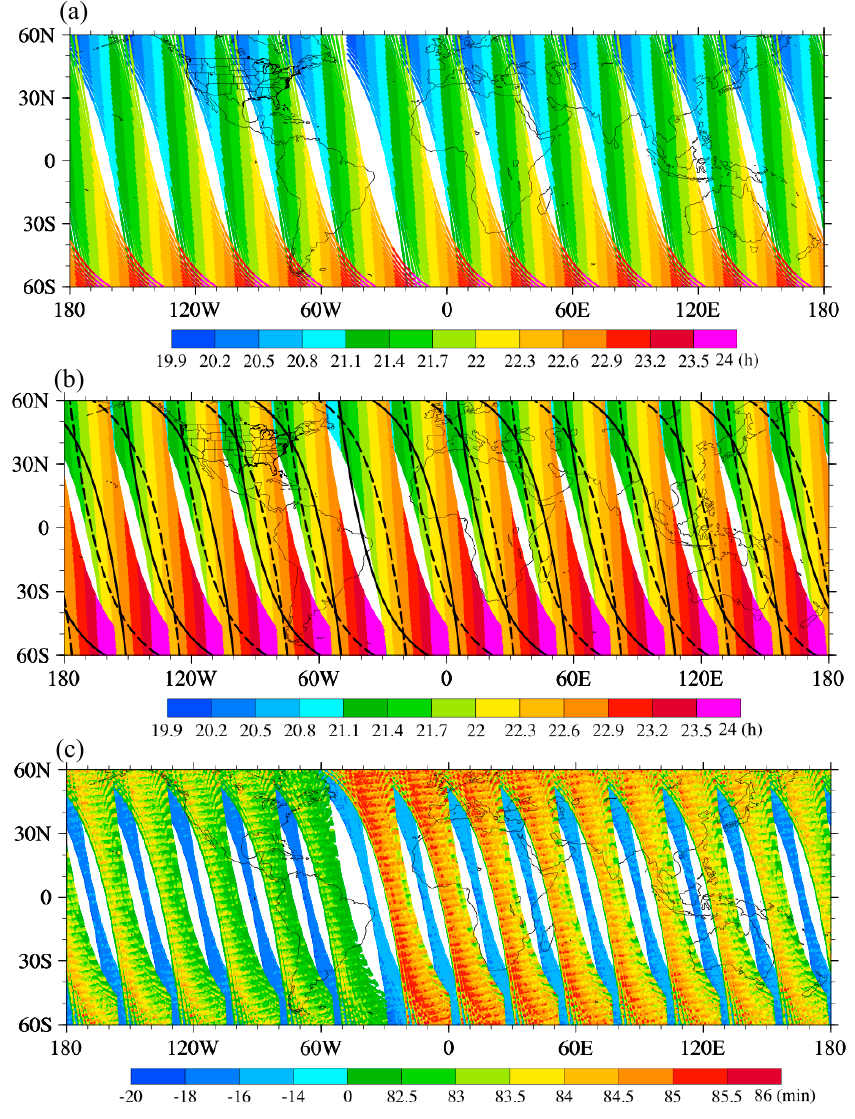
Figure 3. Global distributions of ( a ) MetOp-B AMSU-A local times (LTs), ( b ) FY-3C MWTS-2 LTs, and ( c ) differences (unit: minute) between AMSU-A and MWTS-2 LTs for overlapping swaths from ascending nodes on 15 July 2014. The solid and dashed curves in (b) represent the MetOp-B and AMSU-A swaths, respectively .